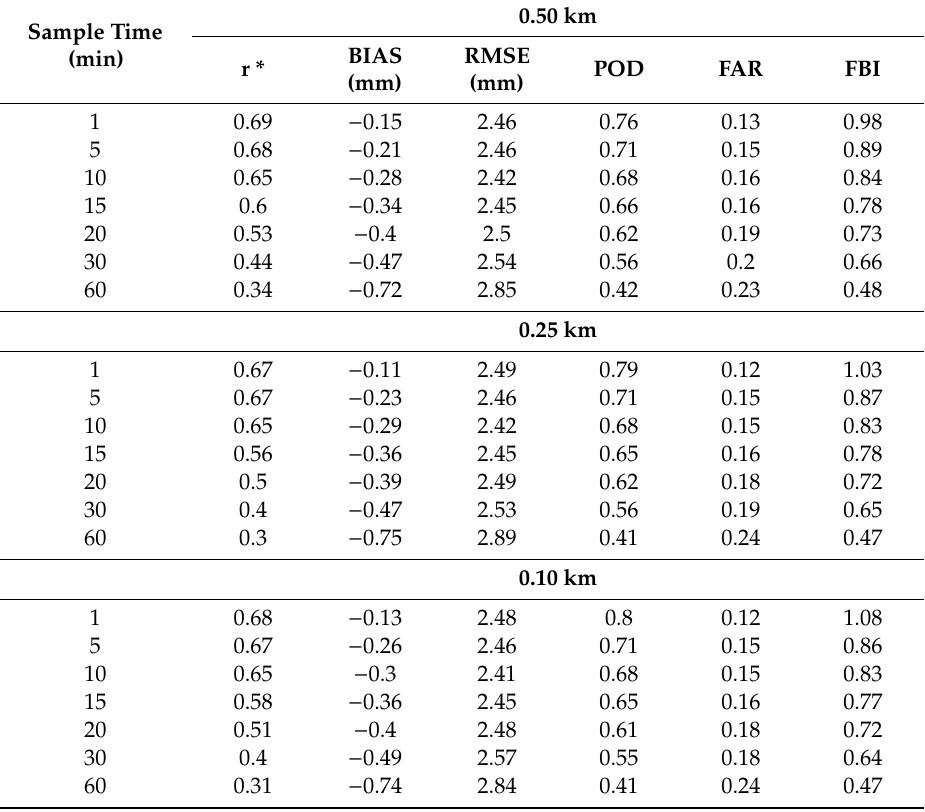
Table 4. Statistical error metrics and detection indexes between radar data and rain gauges for di ff erent spatial and temporal resolutions of radar